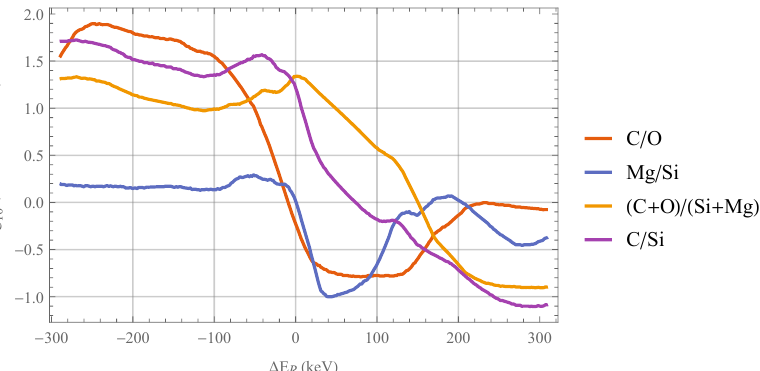
Figure 1. Abundance ratios of various elements as a function of the Hoyle resonance energy. The quantity ∆ E R “ 0 for our values of the